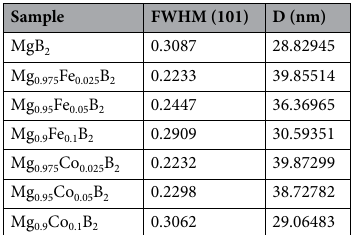
Table 1. FWHM values and crystallite size for pure Mg 1− x TM x B 2 ( x = 0.025, 0.05, and 0.1; TM = Fe and